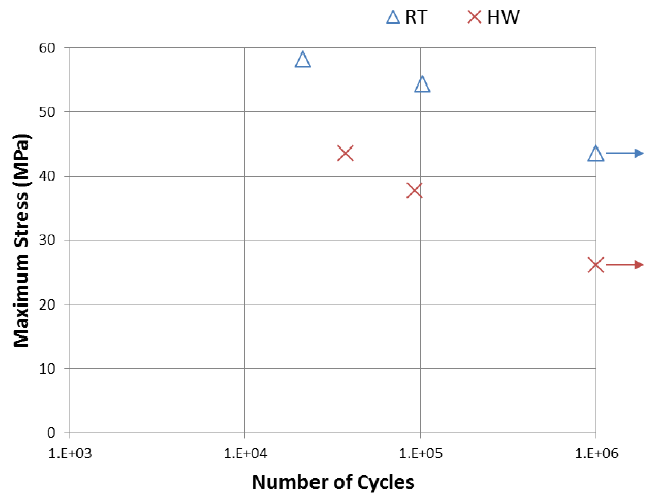
Figure 9. Effect of aging on fatigue interlaminar shear strength. Arrows to the right indicate that no failure has